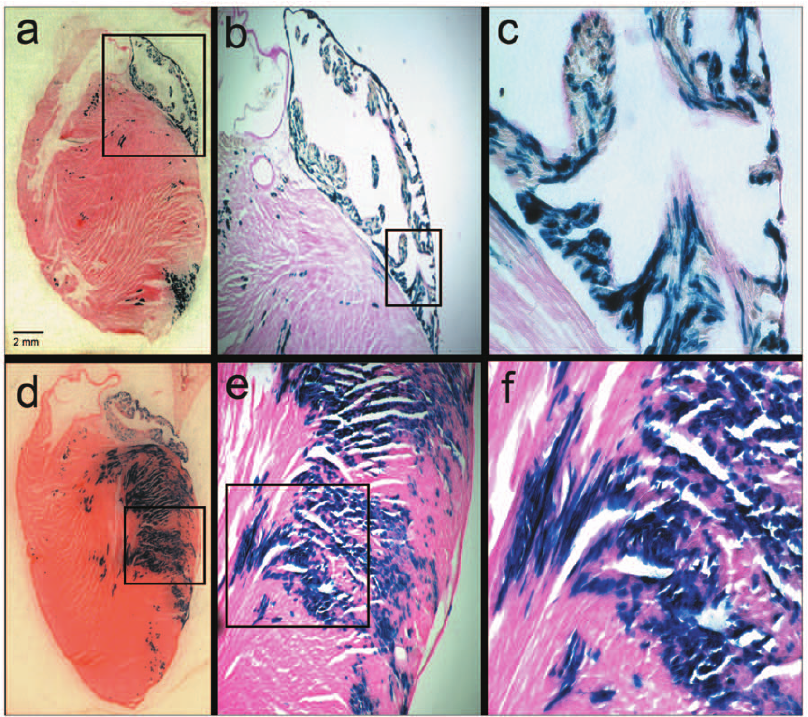
Figure 4. Pnmt-Cre expression in cardiomyocytes of the adult mouse heart. XGAL + staining in the left heart reveals the anatomical location of cells which have historically expressed the Pnmt gene. Pnmt expression can be seen in the LA and the apical border of the LV ( panel a). Pnmt expression is seen distributed throughout the LA and can be seen within the cardiomyocytes under higher magnification (b, c). Pnmt expression is also observed in the free wall of the LV and appears to be within the cardiomyocytes, based on anatomical and morphological characteristics (d–f).